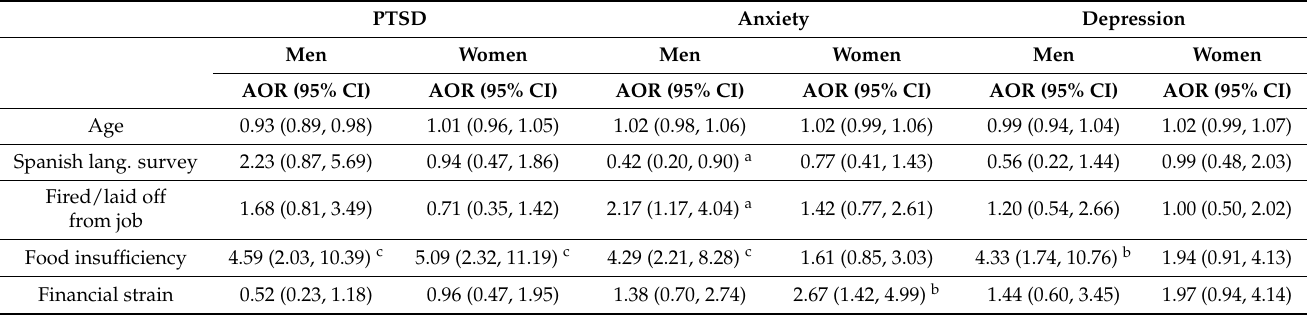
Table 2. Associations between economic stressors and mental health